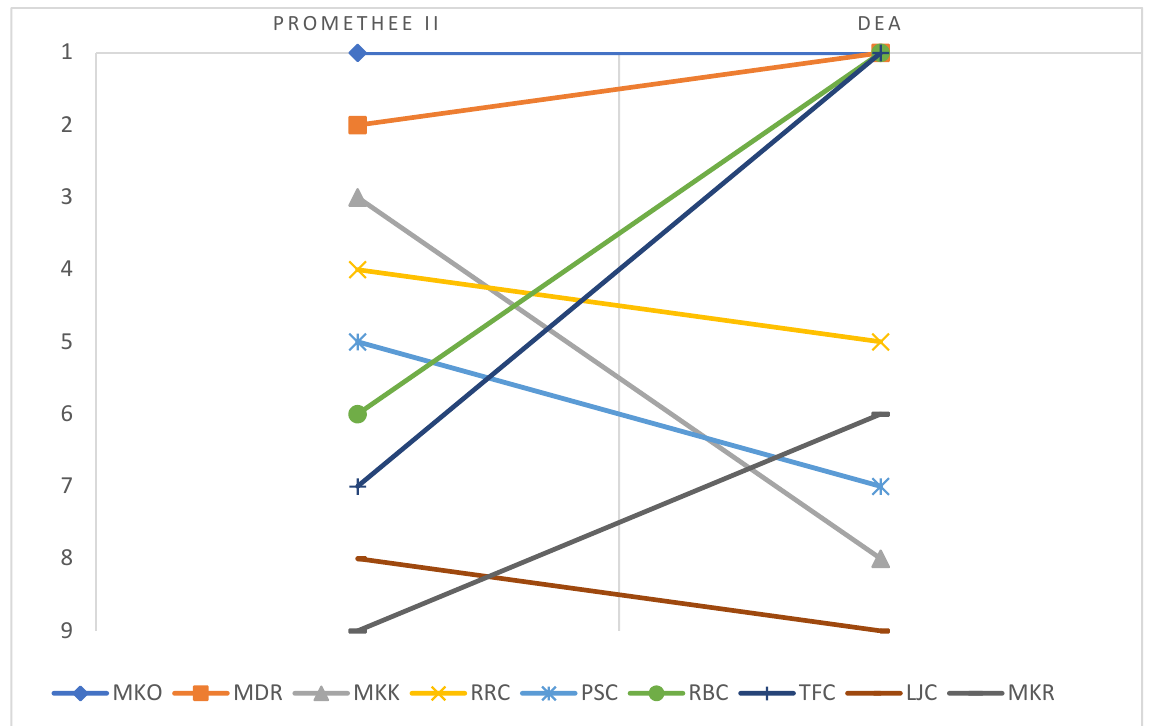
Figure 1. DCs ranking comparison with respect to PROMETHEE II and DEA.